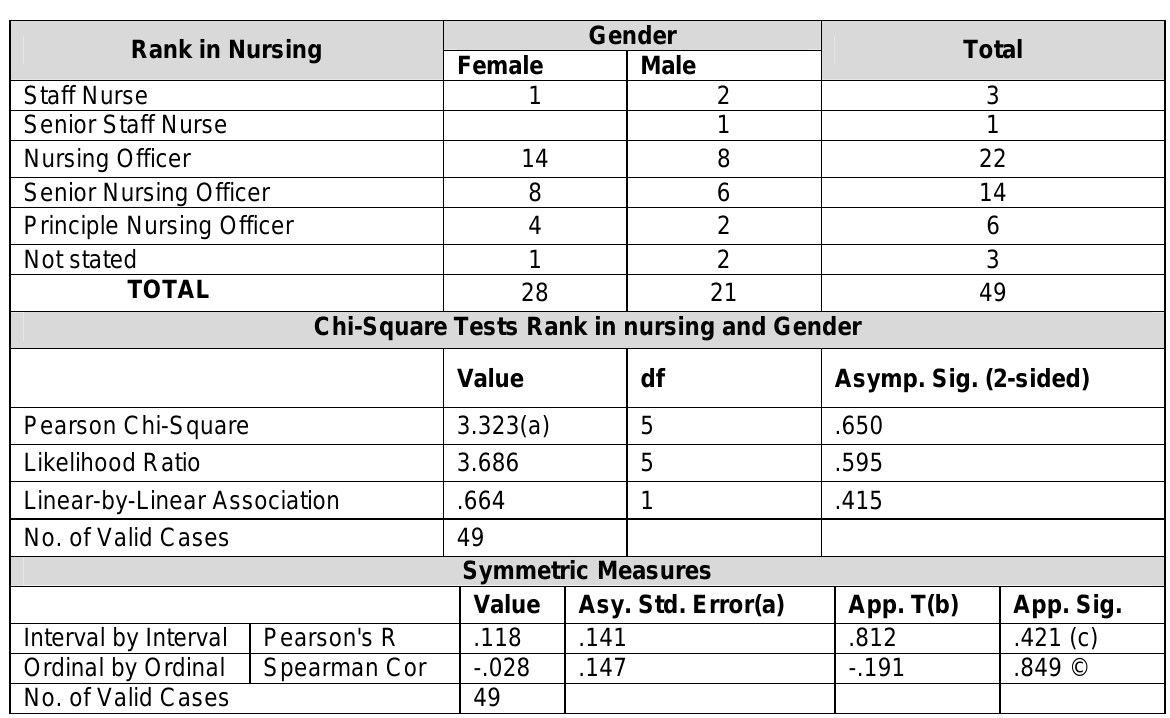
Table 4: Cross-tabulation: rank in nursing and Gender Rank in Nursing